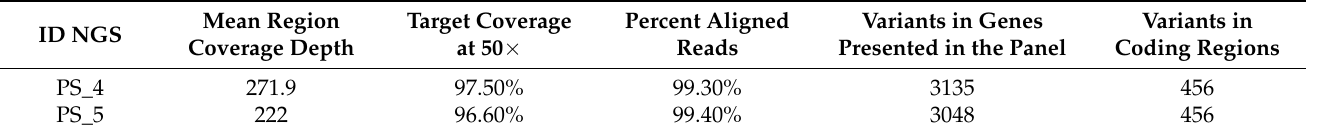
Table 1. Raw sequencing data of the mother and her